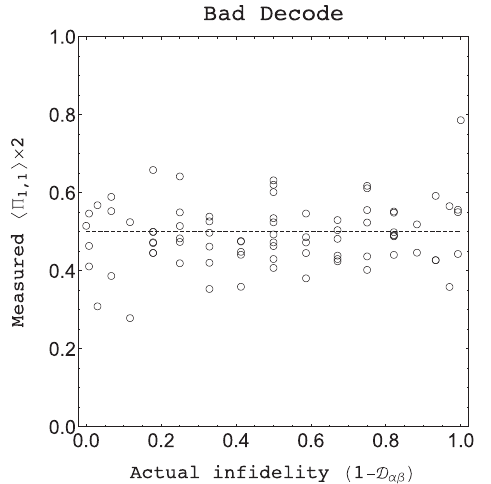
FIG. 18. Plot of measured versus actual infidelity between two states, given wrong decryption. Dashed line indicates expected theoretical values — decrypting with an erroneous key should yield 0.5 (i.e., infidelity relative to the maximally mixed state). Good agreement with this dashed line indicates that result of the computation is well hidden from parties without a valid decryp- tion